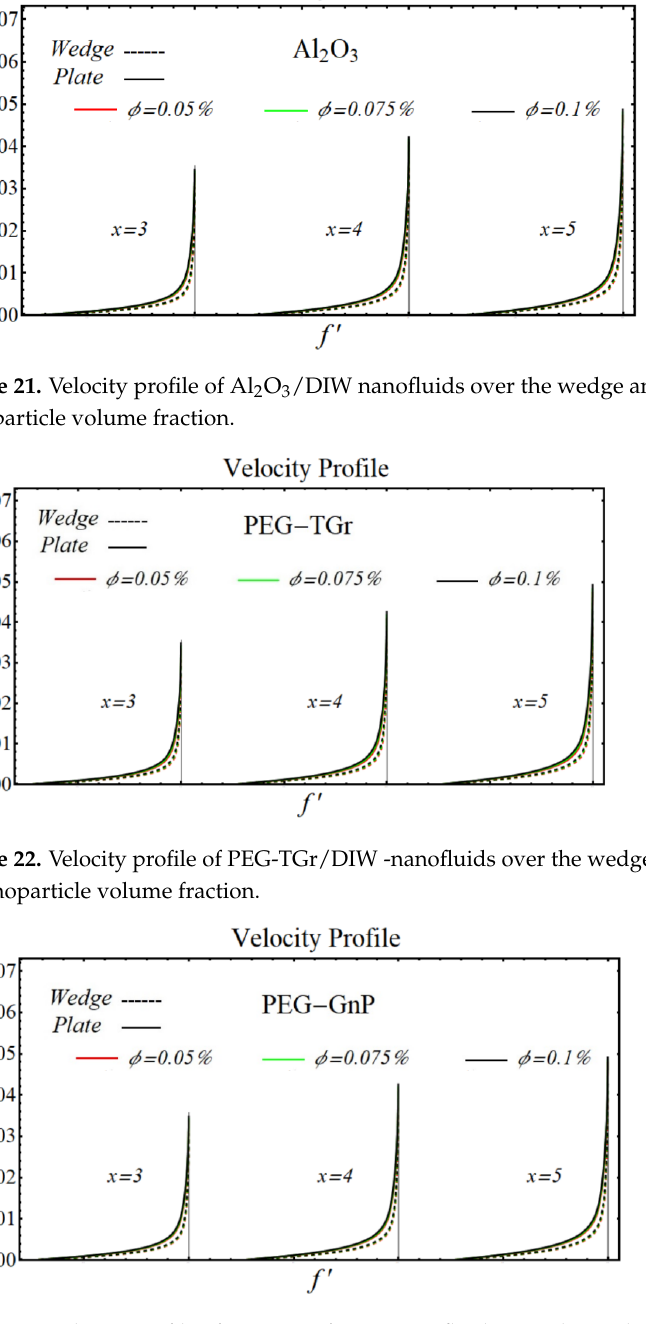
Figure 23. Velocity profile of PEG-GnP/DIW -nanofluids over the wedge and plate under the impact of nanoparticle volume fraction.